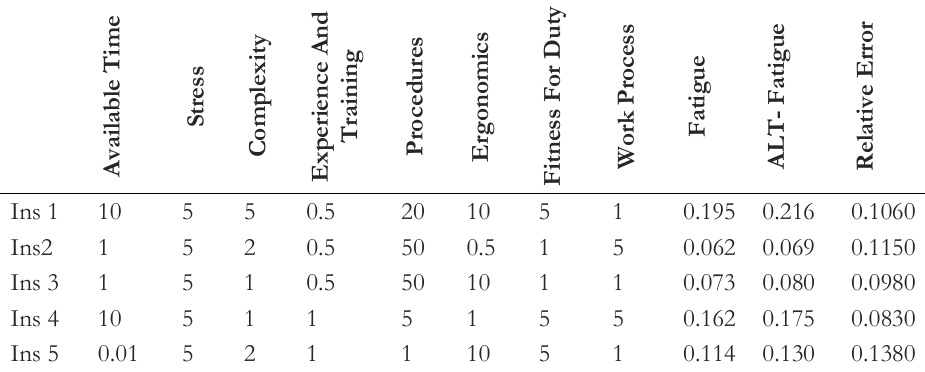
Table 8. The relative fatigue